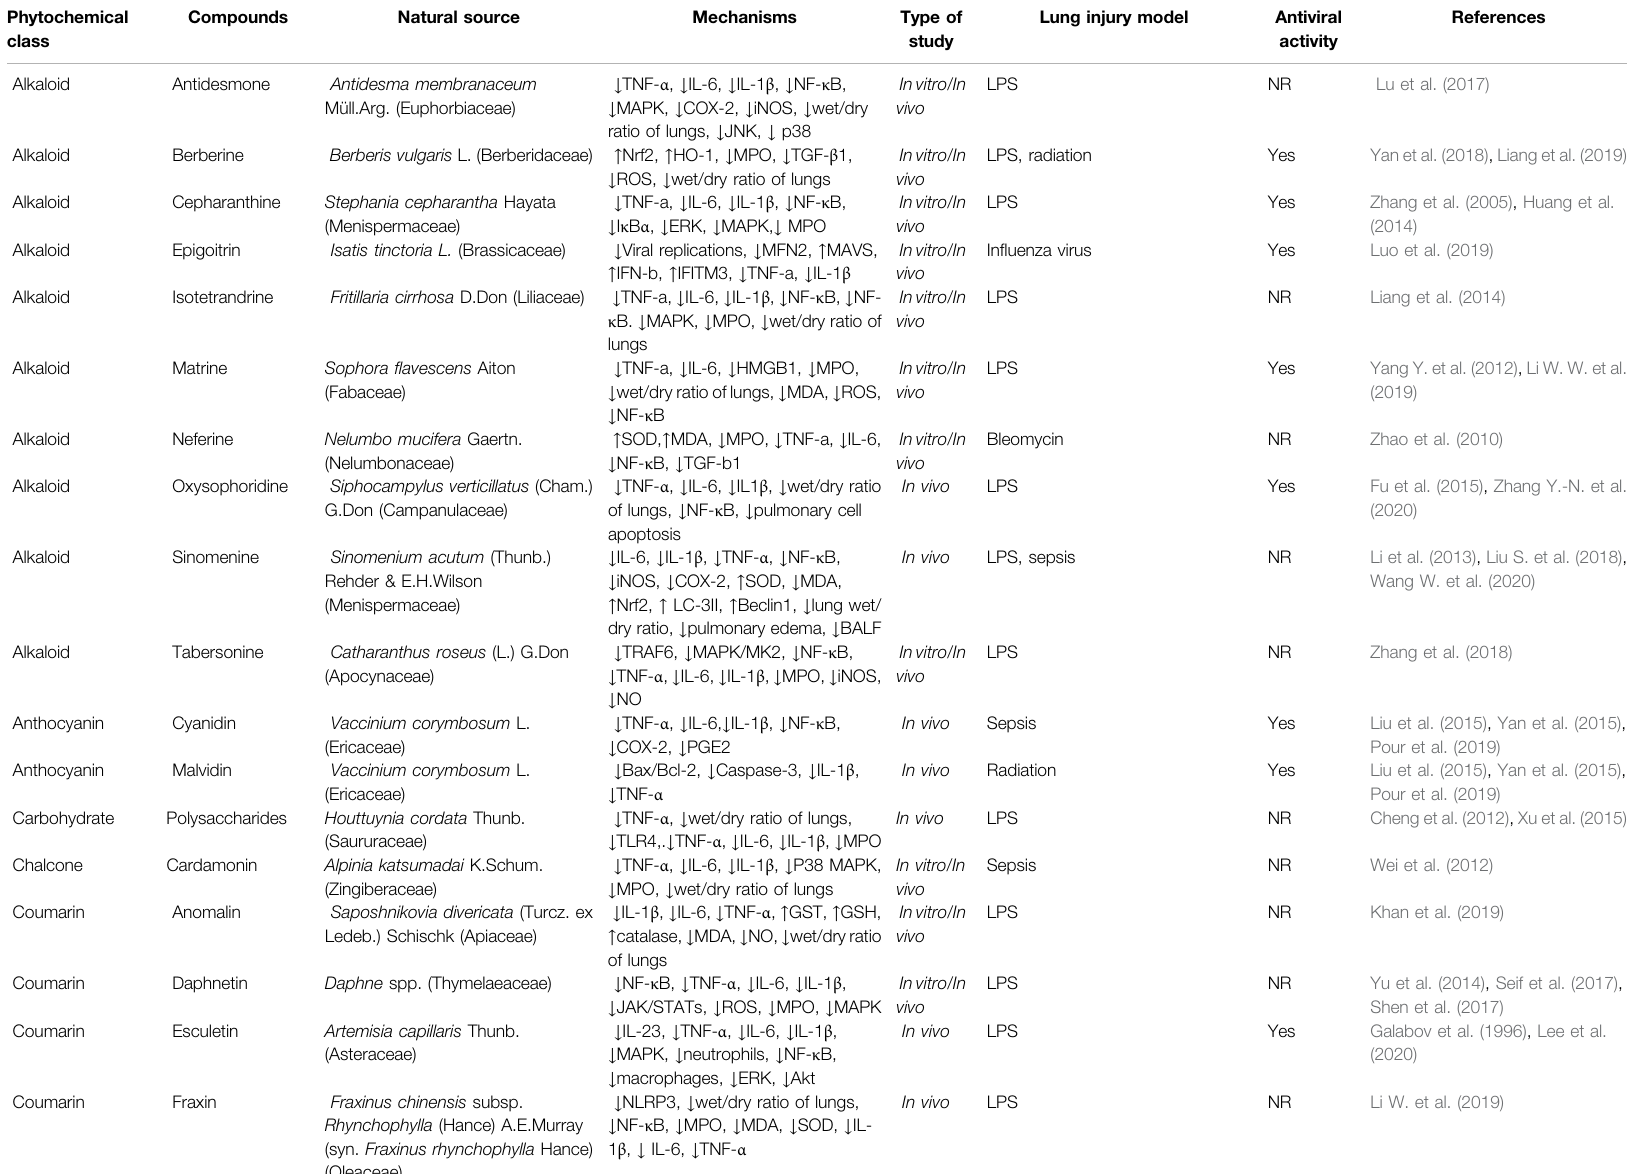
TABLE 1 | Phytochemicals and their mechanisms of action against lung injury. Phytochemical